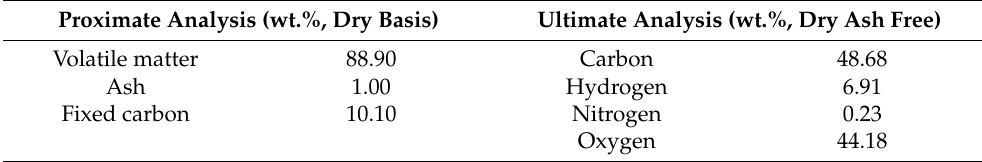
Table 1. Composition of the eucalyptus woodchips. Proximate Analysis (wt.%, Dry